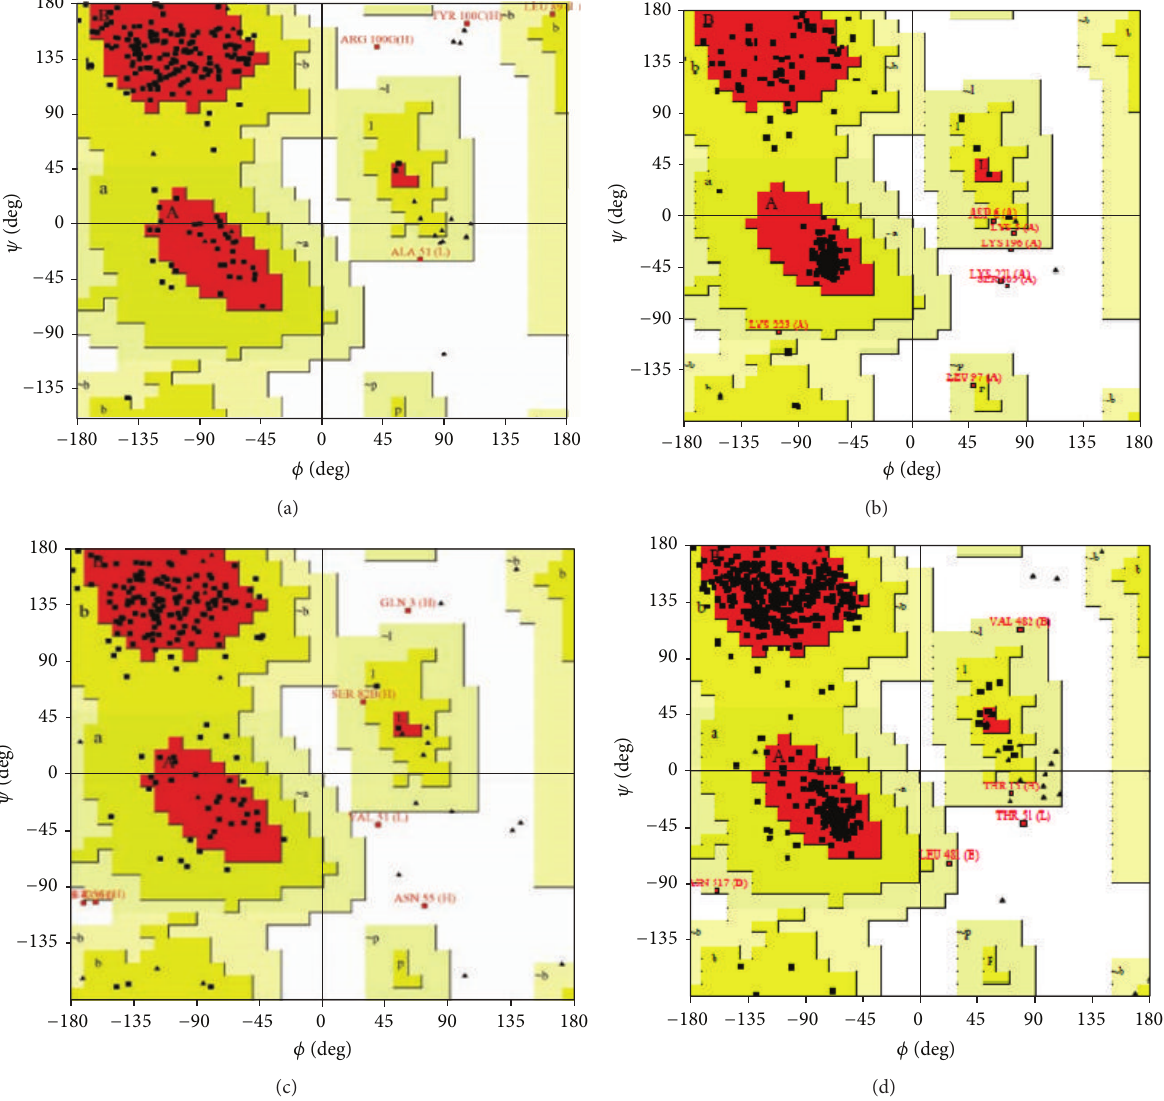
Figure 2: Ramachandran plot of (a) glycoprotein A, (b) glycoprotein B, (c) matrix protein, and (d) small hydrophobic protein. 89.7% of the residues from glycoprotein A, 90.3% of the residues from glycoprotein B, 79.3% of the residues of matrix protein, and 89.9% of the residues from small hydrophobic protein present in most favoured